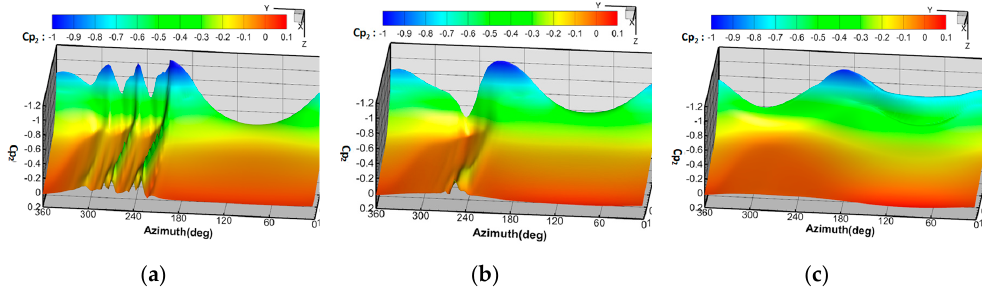
Figure 14. Comparisons of pressure coefficient with different oscillating velocities (k=0.05, α = 10.0 ◦ + 6.0 ◦ sin ( ω t + π ) ). ( a ) λ = 0.0. ( b ) λ = 0.25. ( c ) λ = 0.5.